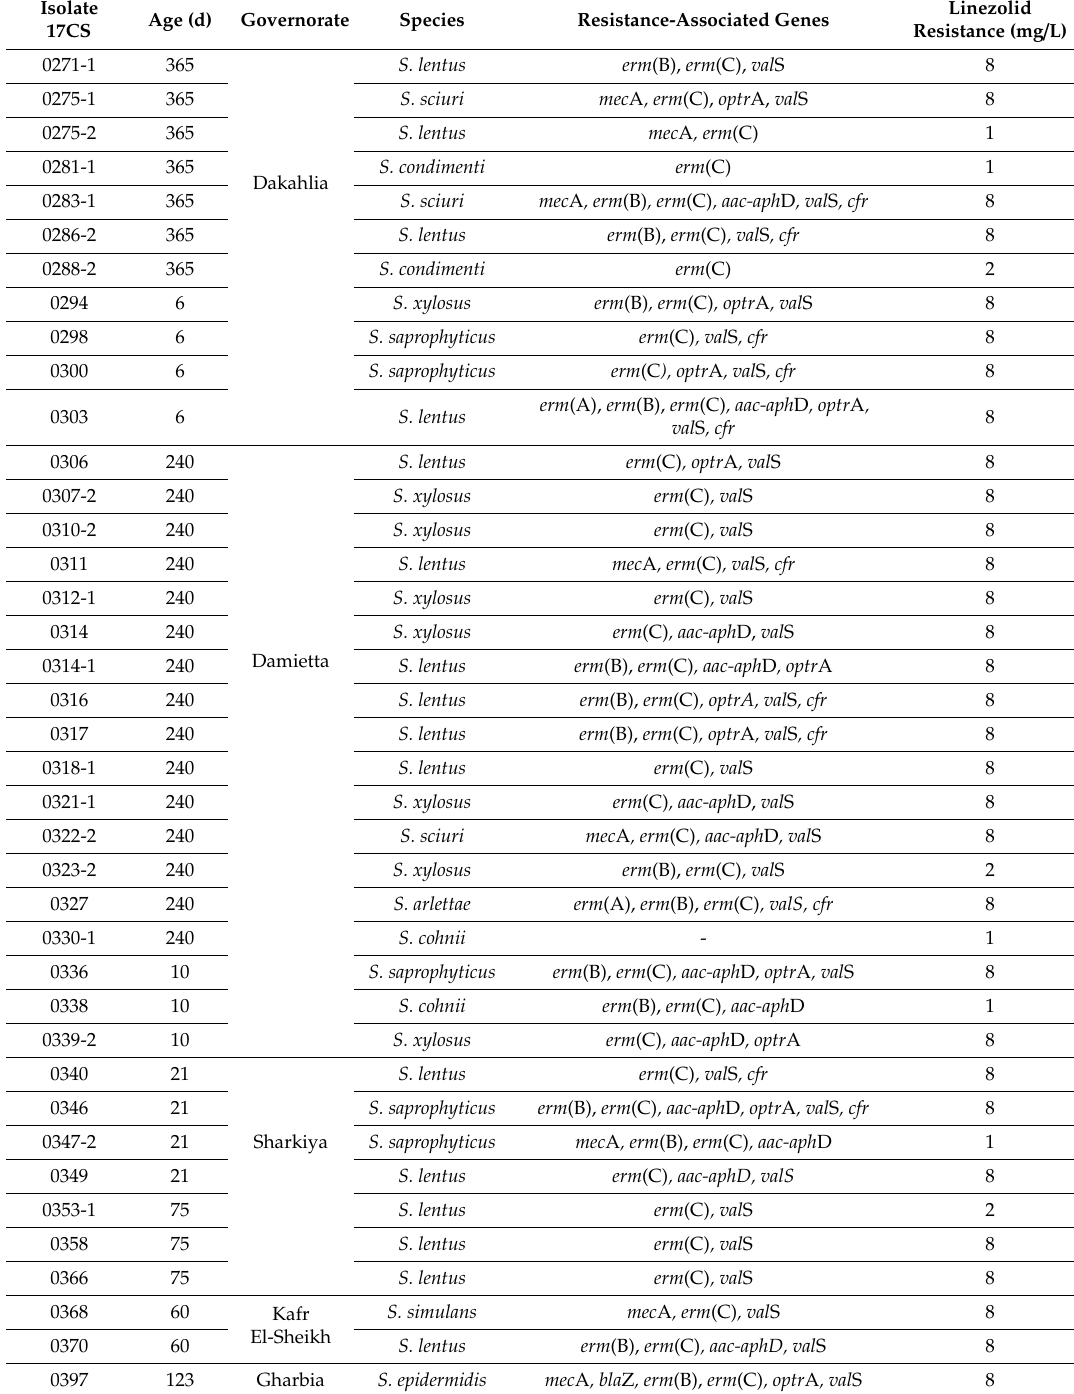
Table 4. Presence of antibiotic resistance genes in coagulase-negative Staphylococcus spp. and phenotypic linezolid